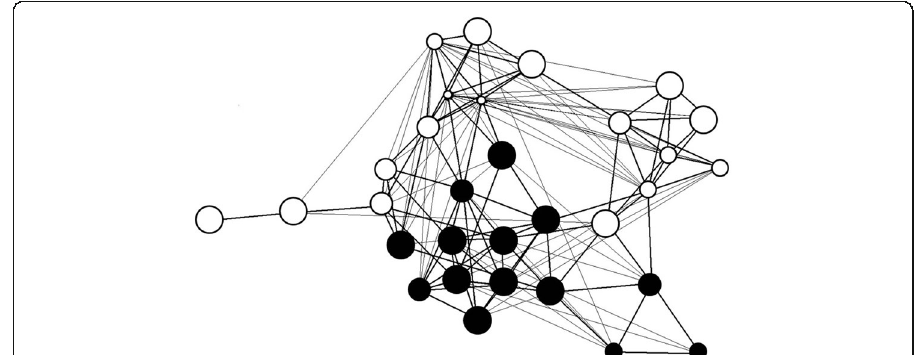
Fig. 5 Social network constructed by using data collected for class h in December 2005 (i.e. class h 0512 dataset). Girls and boys are represented by open circles and filled circles respectively. Thick lines are friend- nominating ties while thin lines are enemy-nominating ties. The size of the nodes reflects the feeling score of the students: larger the node size higher the feeling